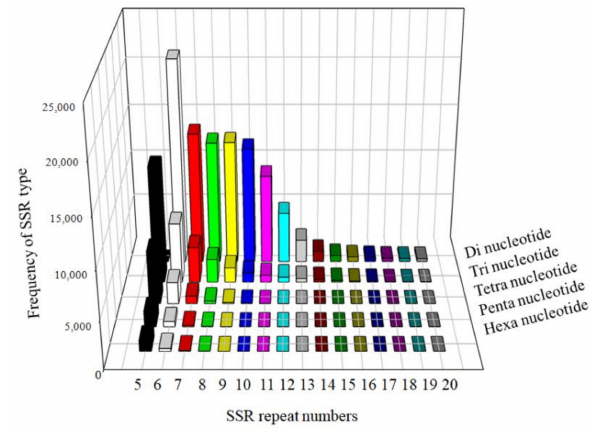
Figure 4. The distribution and frequency of SSR motif repeat